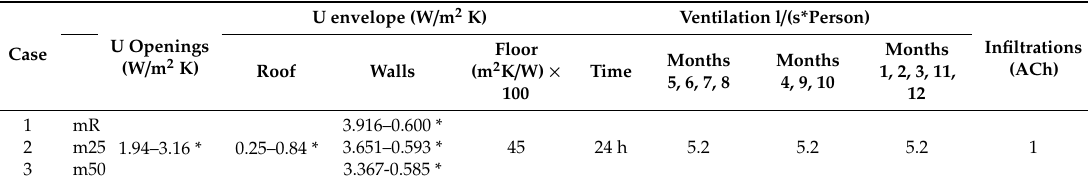
Figure 3. Housing model for the study. Table 3. Thermal constructive properties of the case studies with the three bricks.